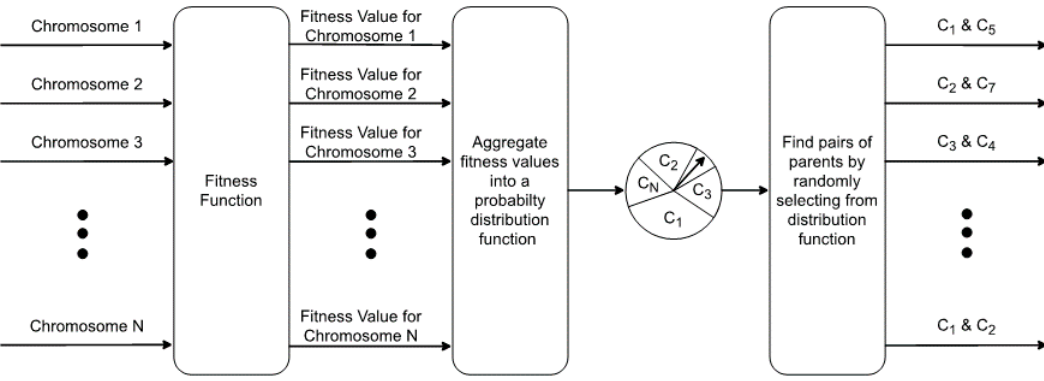
Figure A3. Schematic of a genetic algorithm.